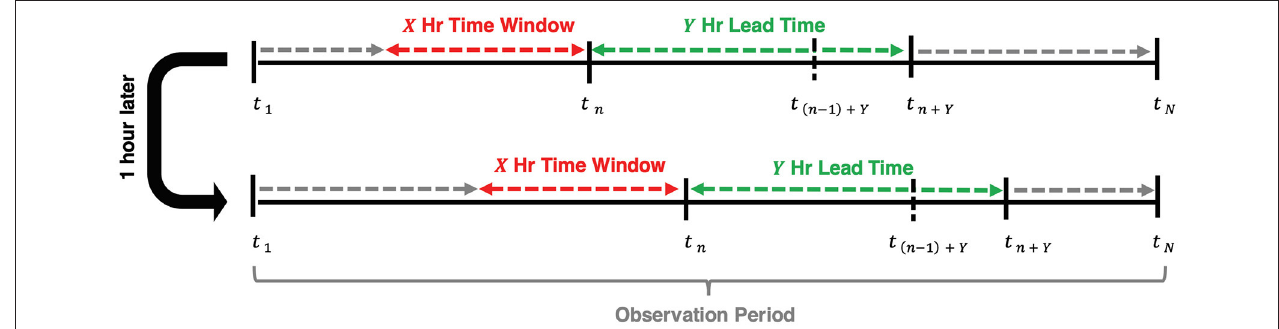
FIGURE 1 | Visual representation of the relationship between time window, lead time, and the time escalation is predicted at each hour, t n , of admission ( n = 1,2,...,N). The observation period begins at the time of admission and concludes at t N when the patient escalates to MV for ventilated patients or at discharge for non-ventilated